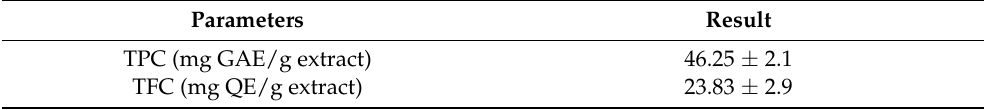
Table 2. Total flavonoid and phenolics contents of ERF of M. arboreus .